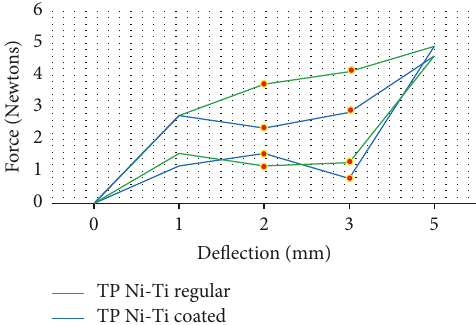
Figure 4: Comparison of the mean force (N) load and unload deflection between coated and regular Borgatta 0.016 󸀠󸀠 Ni-Ti wires. TherewasastatisticallysignificantdecreaseinthecoatedNi-Tiwires at 2 mm ( 𝑝 < 0.001 ), 3 mm ( 𝑝 < 0.001 ), and 5 mm ( 𝑝 < 0.0001 ) load deflection compared with regular Ni-Ti wires. For the unload deflection, the coated Ni-Ti wires showed a significantly decreased deflection at 1mm ( 𝑝 < 0.01 ) and 2 mm ( 𝑝 < 0.01 ) compared with the regular Ni-Ti wire.